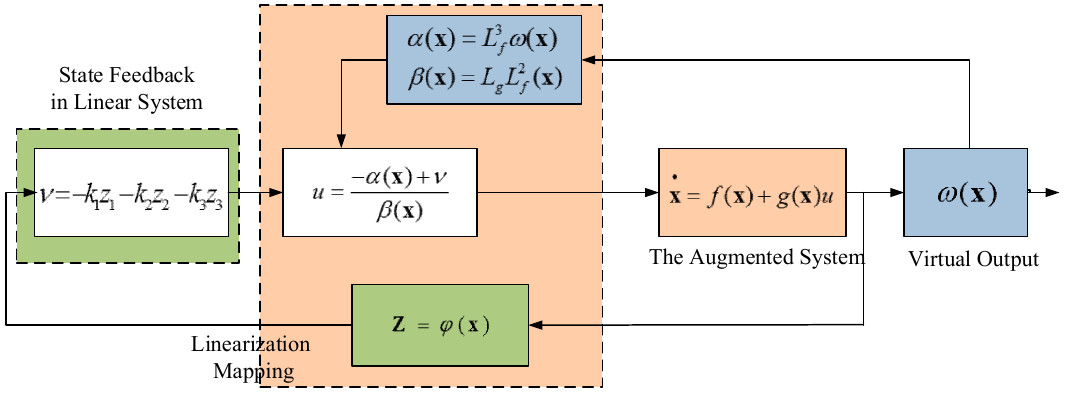
Figure 8. Augmented state-space feedback linearization control strategy.